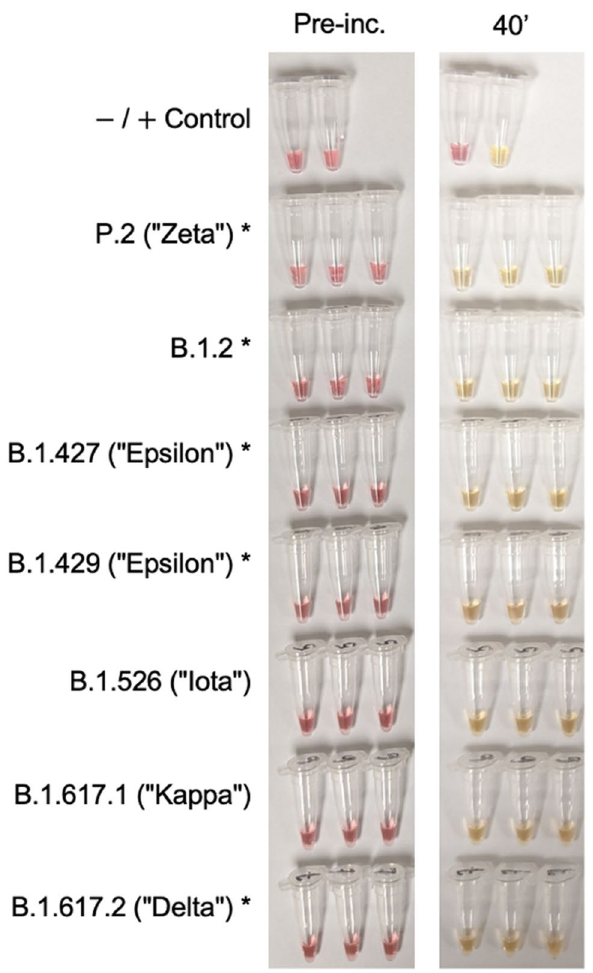
Figure 4. Validation of the RT-LAMP home test on additional heat inactivated SARS-CoV-2 variants (calculated viral copy numbers per tube): P.2 (6.60 × 10^4), B.1.2 (2.69 × 10^5), B.1.427 (5.05 × 10^5), B.1.429 (4.12 × 10^4), B.1.526 (2.72 × 10^5), B.1.617.1 (1.65 × 10^5) and B.1.617.2 (4.05 × 10^4). Negative and positive controls were nuclease-free water and commercially available genomic RNA (BEI), respectively. Asterisk indicates viruses originating from clinical samples, confirmed by sequencing.